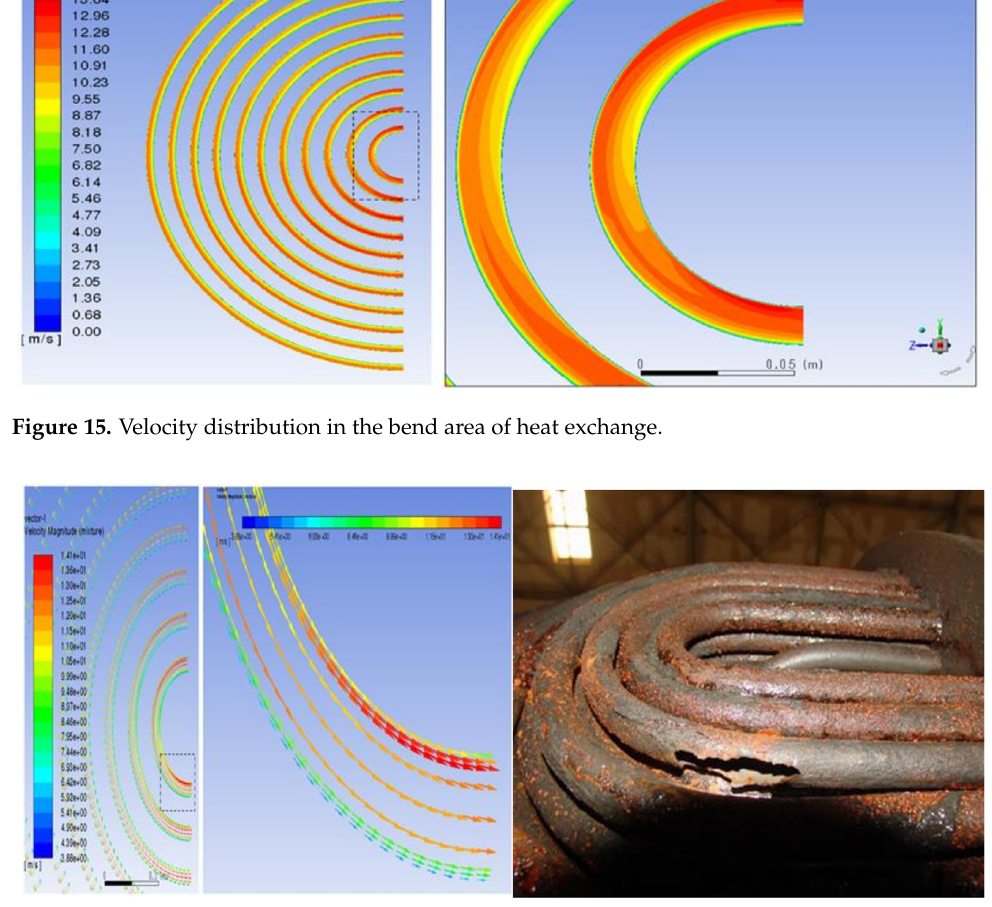
Figure 16. Comparison between simulated results of the elbow area and actual perforated